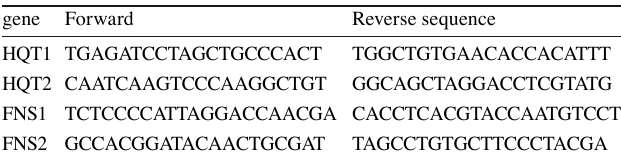
Associated gene transcription in the leaves and buds of LJ , LH